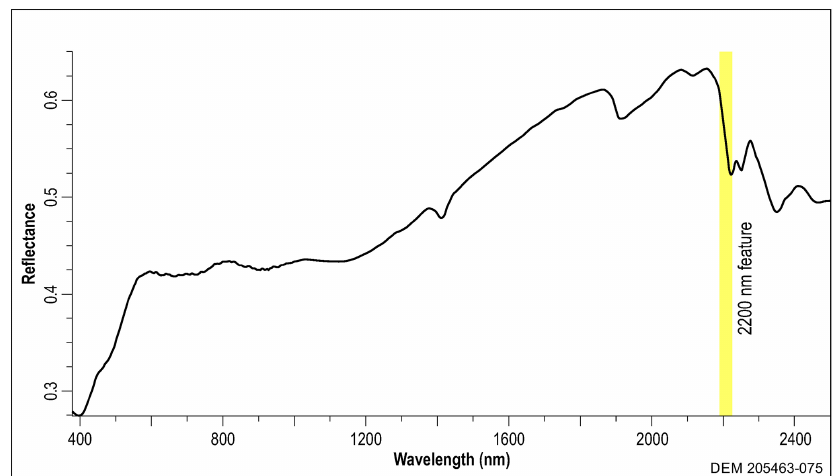
Figure A1. A representative spectral measurement from a sample in this study. The 2200nm feature is highlighted to demonstrate its position relative to the VNIR–SWIR spectral signature.